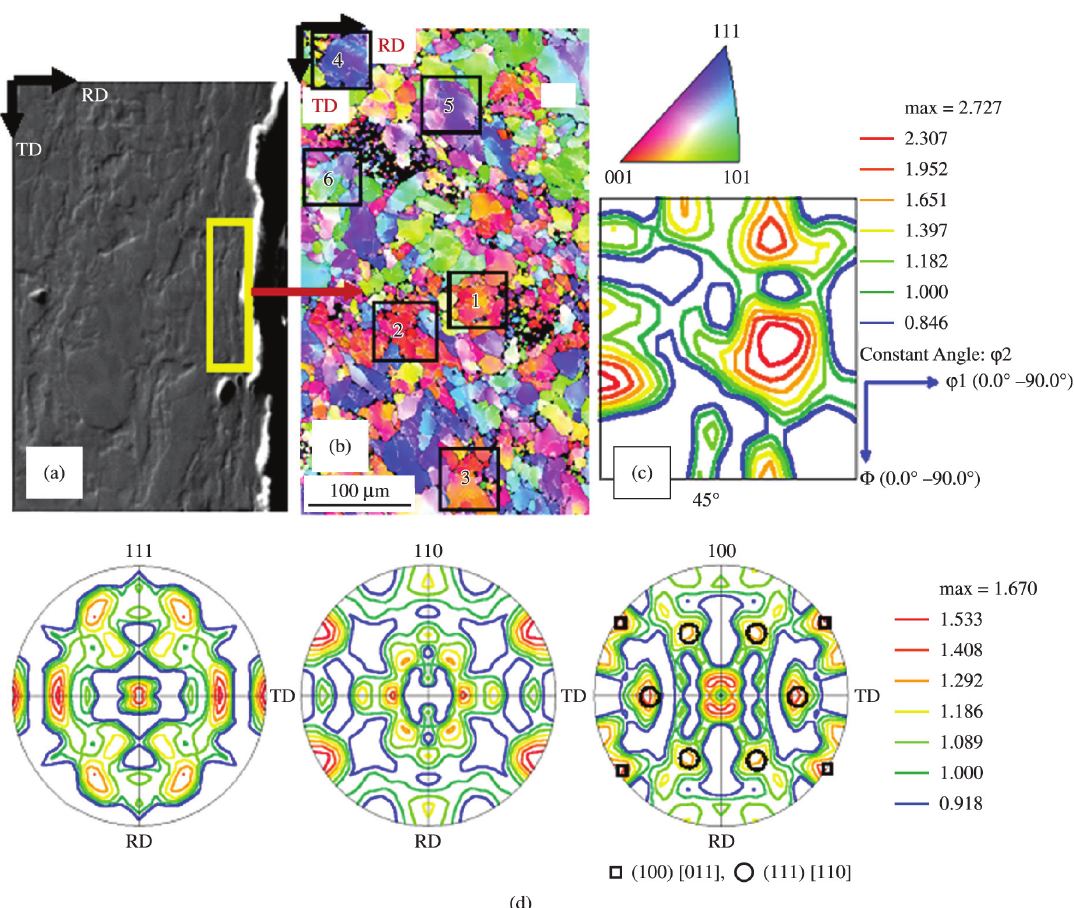
Figure 16. Orientation distributions map: a) SEM scanned region; b) orientation distribution maps, magnification of 1000X; c) orientation distribution function; d) pole